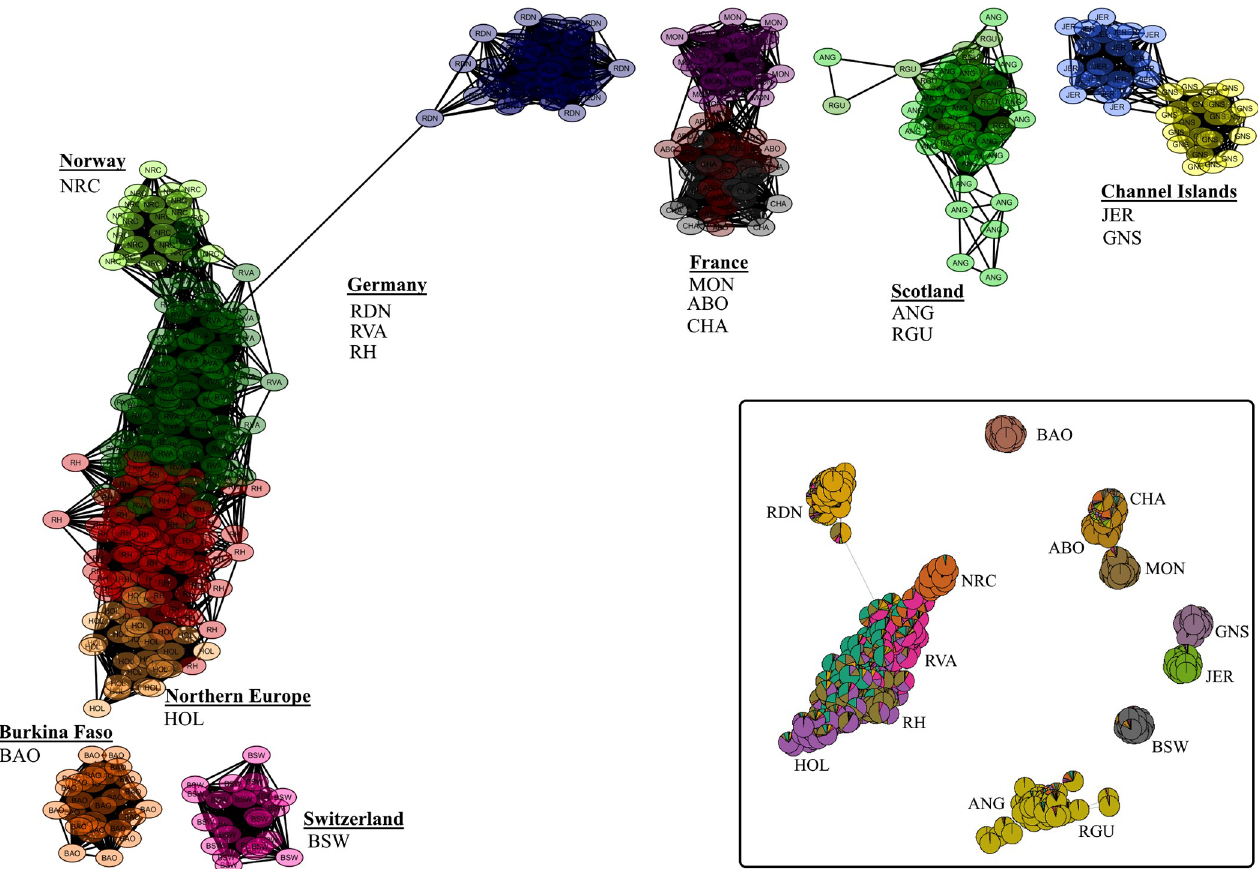
Fig 8. Network visualisation of 14 cattle breeds effectively separated along geographical lines with K-NN = 35. Admixture results at k = 19 were included in the network construction (in Box) such that node colouration reflects individual level of admixture.